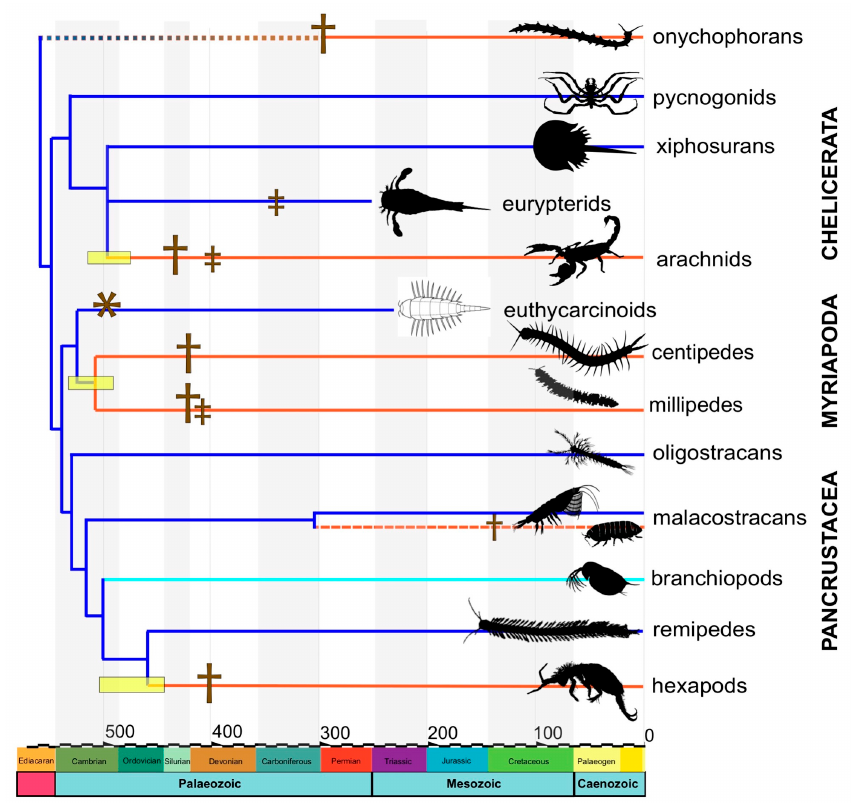
Figure 4. Schematic chronogram with divergence times between the most representative arthropod clades. The internal nodes of the tree fall into the mean estimated divergences taken from recent studies cited in the text. On the x-axis, time runs from most recent (right) to the past (left), and is expressed in millions of years. The yellow rectangles mark the credibility intervals for the different terrestrialization phenomena. The dagger symbol represents the oldest known fossil in that terrestrial group, the double dagger represents the oldest direct evidence of terrestrial breathing structures, and the asterisk the oldest trace evidence of terrestrial behaviour. The terrestrial groups are represented in orange colours while the marine clades in blue and turquoise for Branchiopoda (fresh water). Some of the silhouettes are from Phylopic (phylopic.org/; accessed on 5 November 2022).